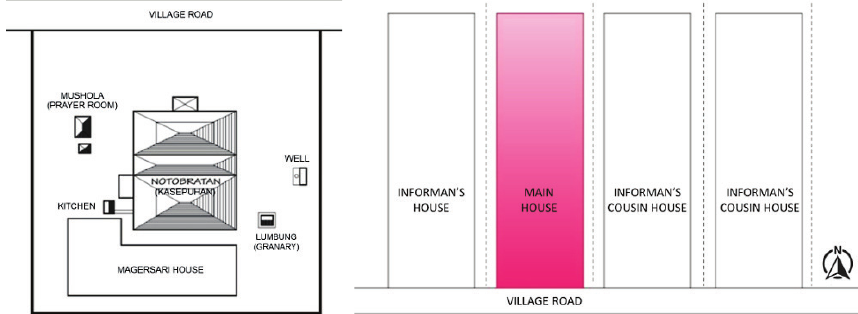
Figure 4. The Joglo Limasan shape with spacious yard and fence is the characteristic of noble houses while the commoners’ houses are simple and gable-roofed (source: Survey,